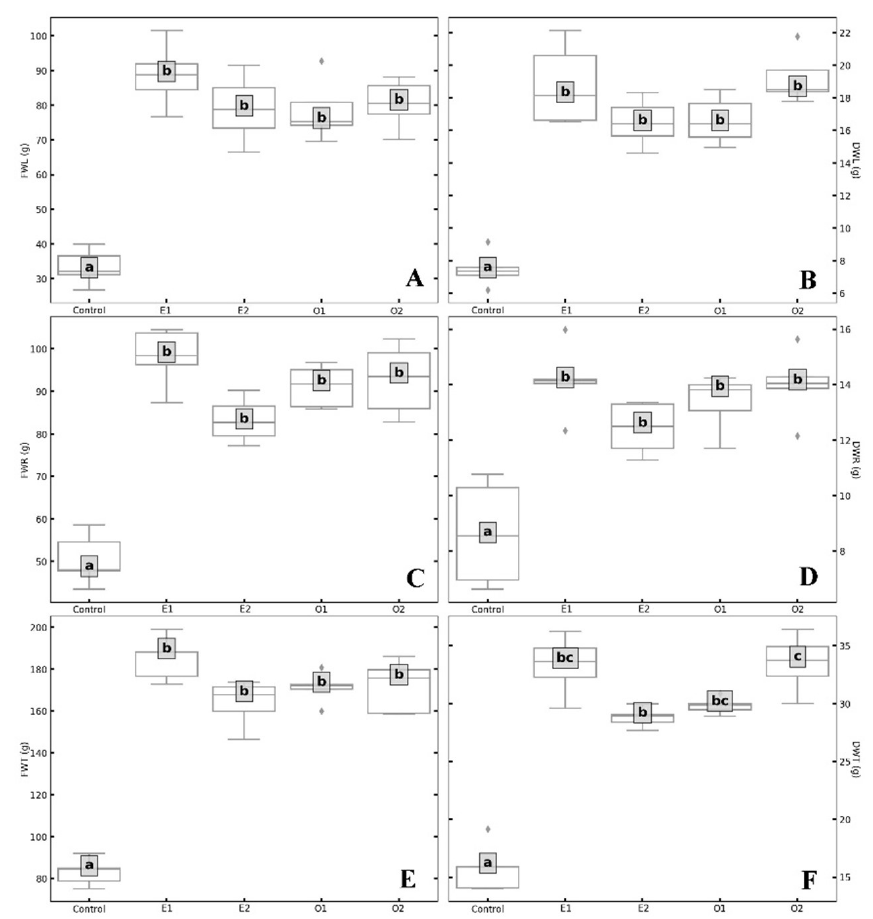
Figure 1. Box plots representing the variation in plant growth at the end of the treatments, for ( A ) leaf fresh weight, ( B ) leaf dry weight, ( C ) root fresh weight, ( D ) root dry weight, ( E ) total fresh weight, and ( F ) total dry weight in response to the application of EM and OWM biostimulants at two concentrations in Tanacetum balsamita plants. The central line displays the median, the bottom and top of the box are the first and third quartiles. Different letters indicate significant differences ( p < 0.05) using the Tukey’s